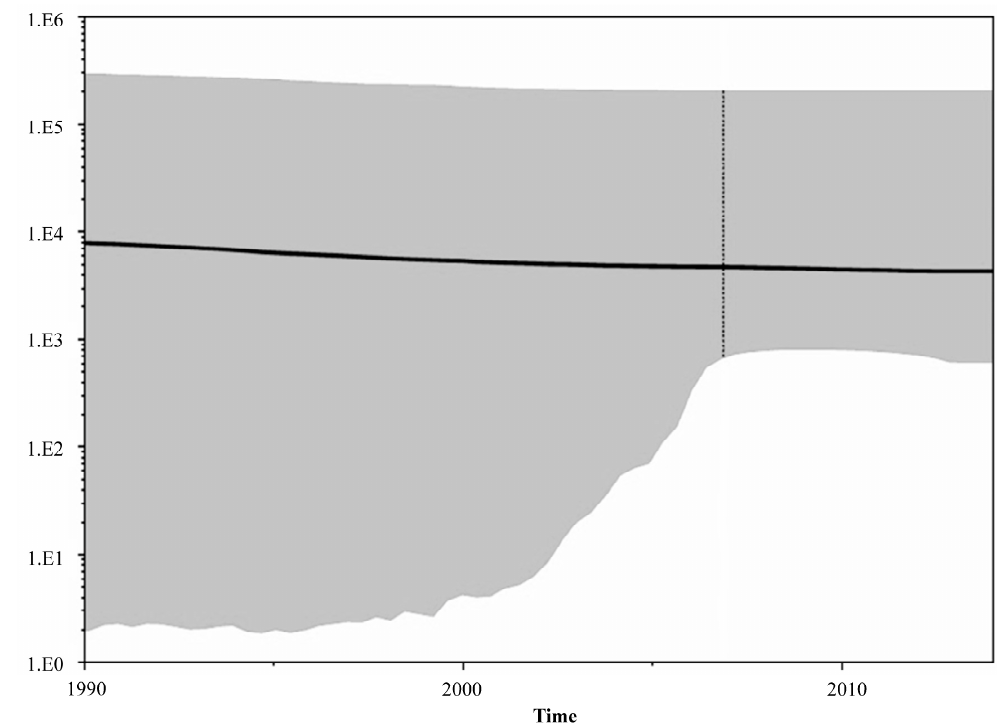
Figure 3. Bayesian skyline plots for the HIV-1 recombinant B/D in Puerto Rico (2011–2014). ( n = 40) The plots represent number of effective population size ( Y = log10) through time ( X = time). The line represents the median of number of lineages with upper and lower 95% highest posterior density interval (HPD) estimates. The mean mutation rate was estimated as 1.665 × 10 − 3 nucleotide substitutions per site per year. A constant rate of evolution is observed in the last decade.